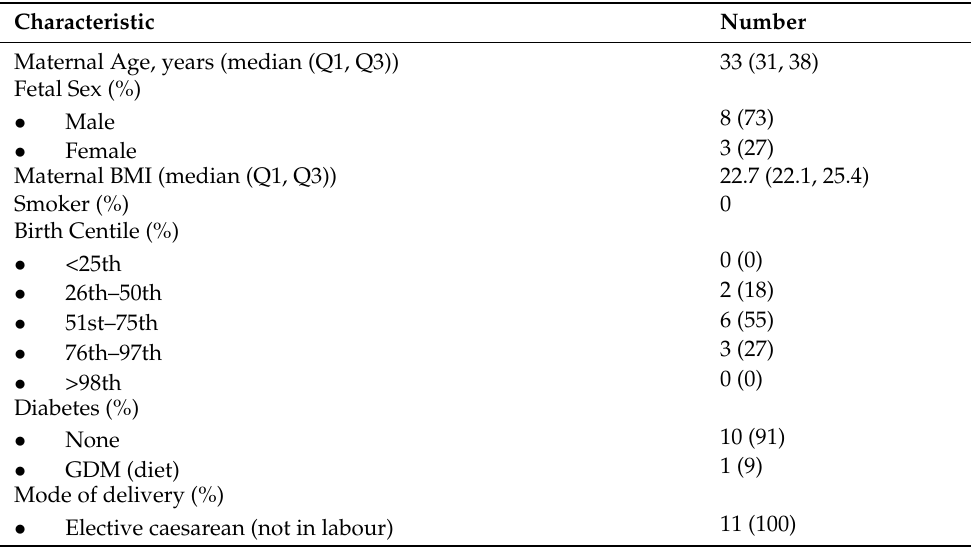
Table 1. Patient characteristics for term gestational tissue